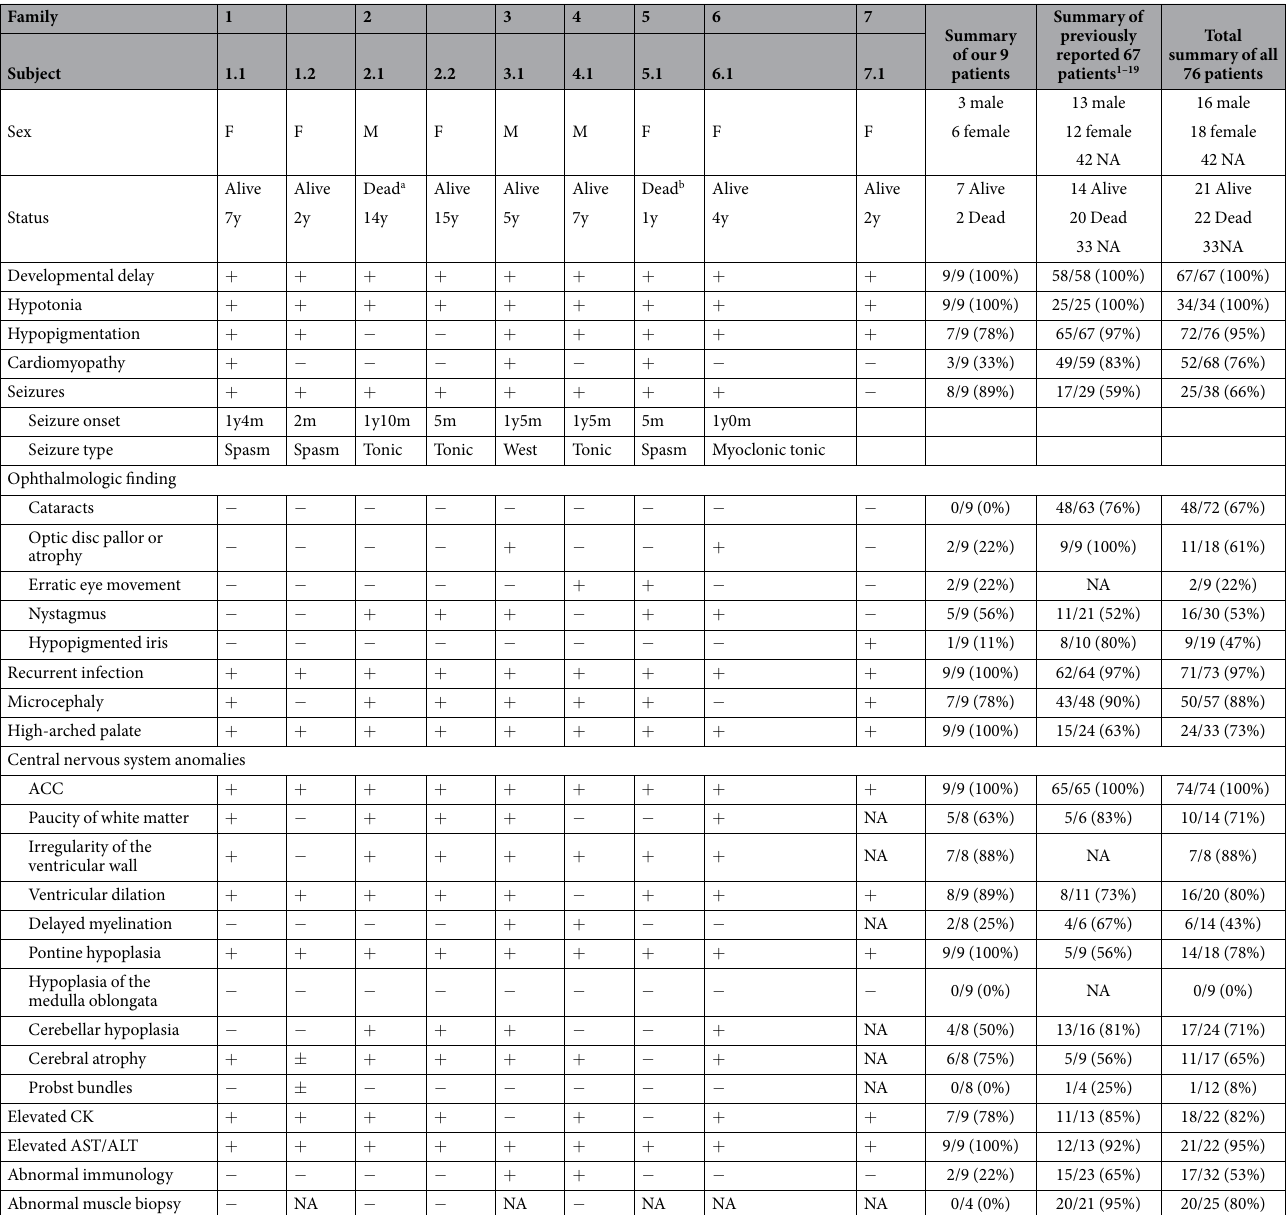
Table 1. Clinical features of nine patients with Vici syndrome in current study and summary of previous reports. F = female, M = male, ACC = agenesis of the corpus callosum, NA = not available, CK = creatine kinase, AST = aspartate transaminase, ALT = alanine transaminase, a Patient 2.1 died at the age of 14 years